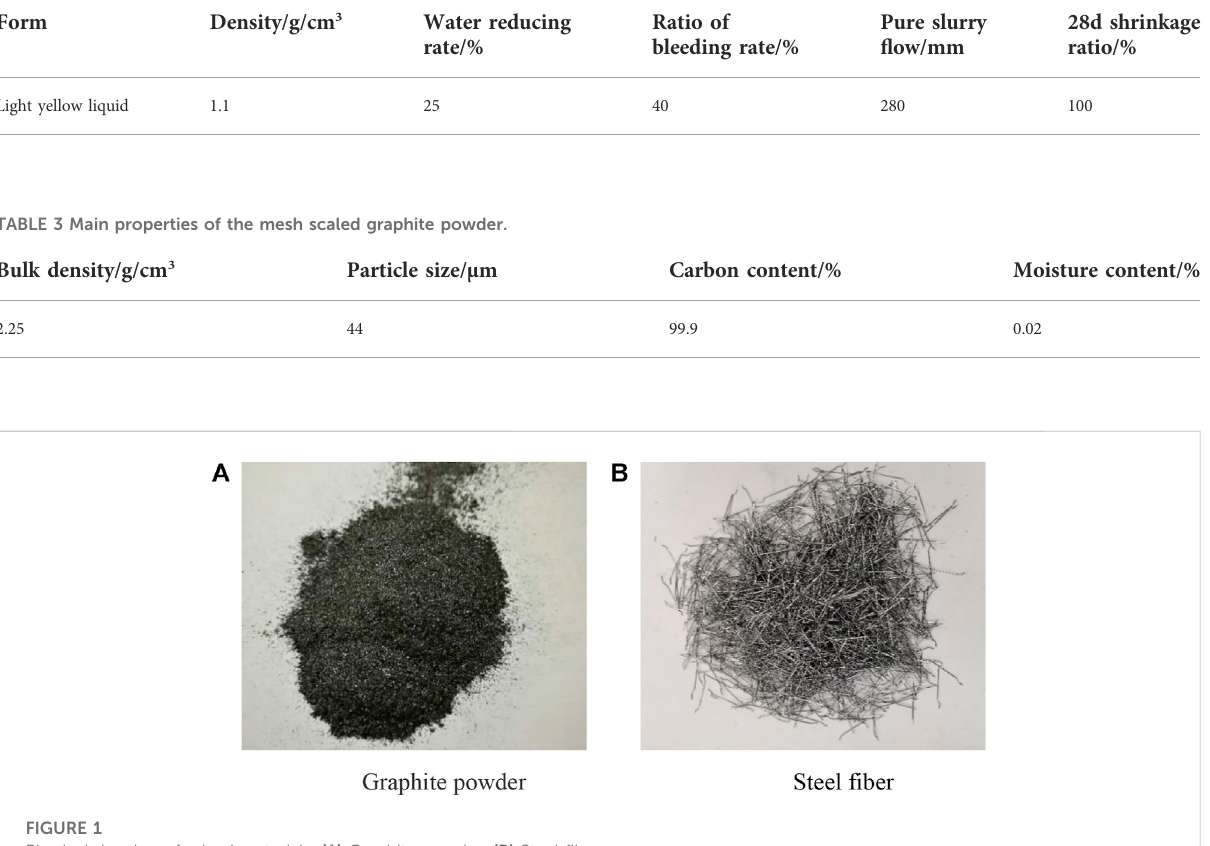
TABLE 2 Physical properties of the polycarboxylic acid water reducing agent.